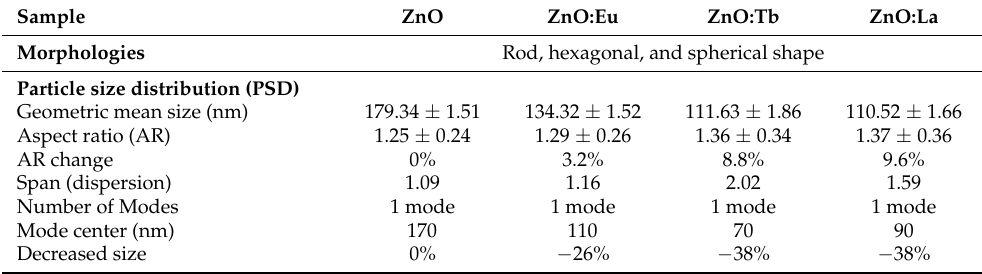
Table 1. Morphological and size distribution from TEM micrographs of ZnO, ZnO:Eu, ZnO:Tb, and ZnO:La NPs.